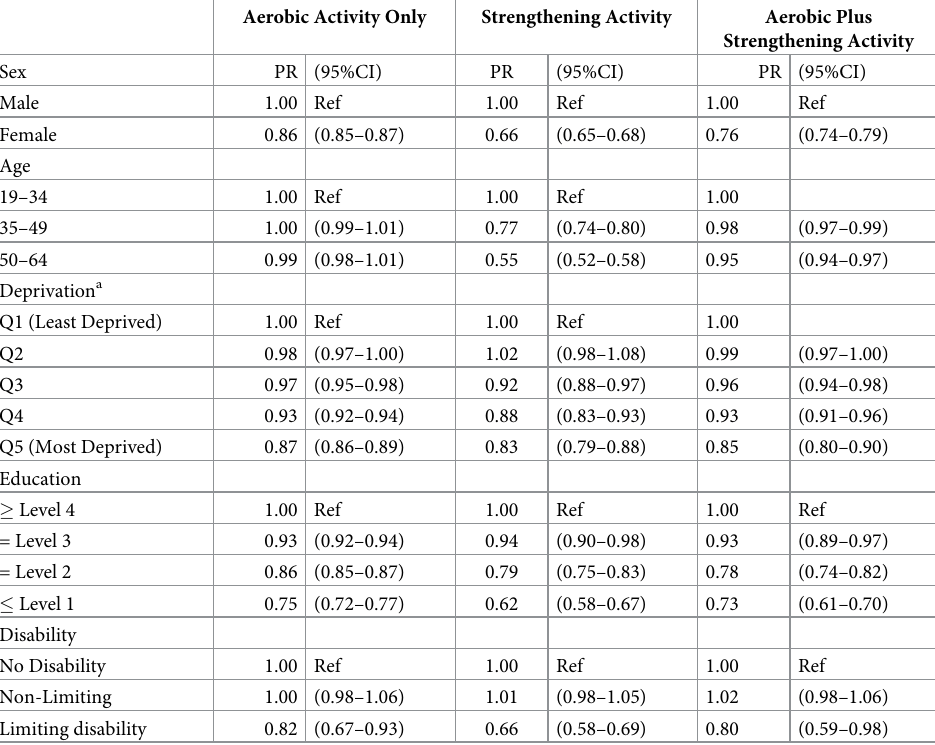
Table 2. Factors associated with meeting current UK guidelines for aerobic activity, strengthening activity and combined aerobic plus strengthening activity in a nationally representative sample of English adults aged 19–65